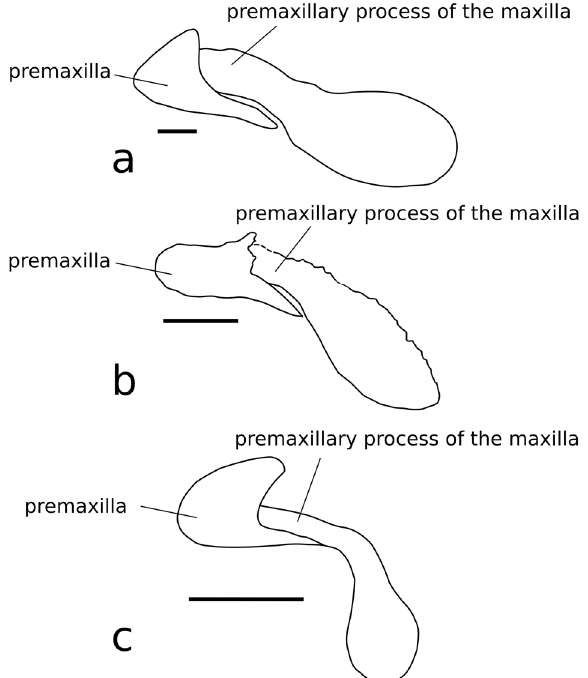
Fig. 3 . Outlines of the premaxilla and the maxilla in three chanid genera in order to compare the relative length and curvature of the premaxillary process of the maxilla in: a